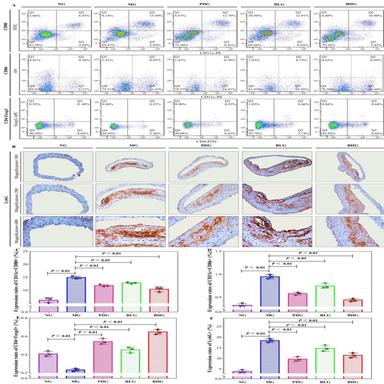
Representative images of flow cytometric analysis from CD11c + CD80+ cell, CD11c + CD86+ cell and CD4 + Foxp3+ Treg cell of ApoE−/− mice (A). Representative immunohistochemical images of aortic sections stained with Ly6G antibody (B). Statistical analysis chart of CD11c + CD80+ (C), CD11c + CD86+ (D), CD4 + Foxp3+ (E), Ly6G+ (F) expression level.